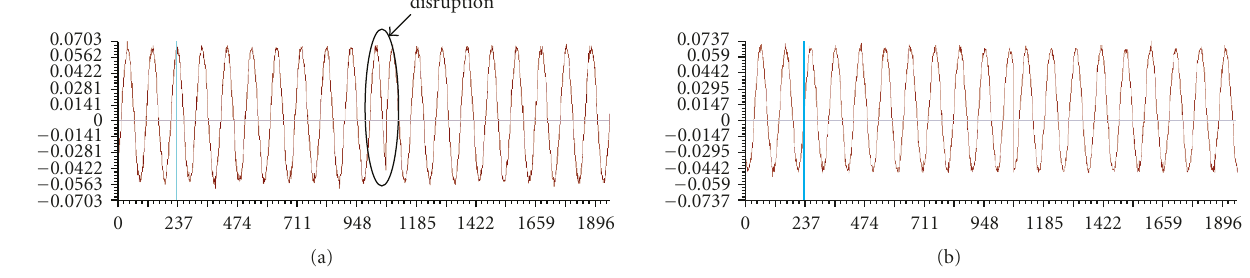
Figure 10: Channel 1 demodulated I and Q signals using CCS.